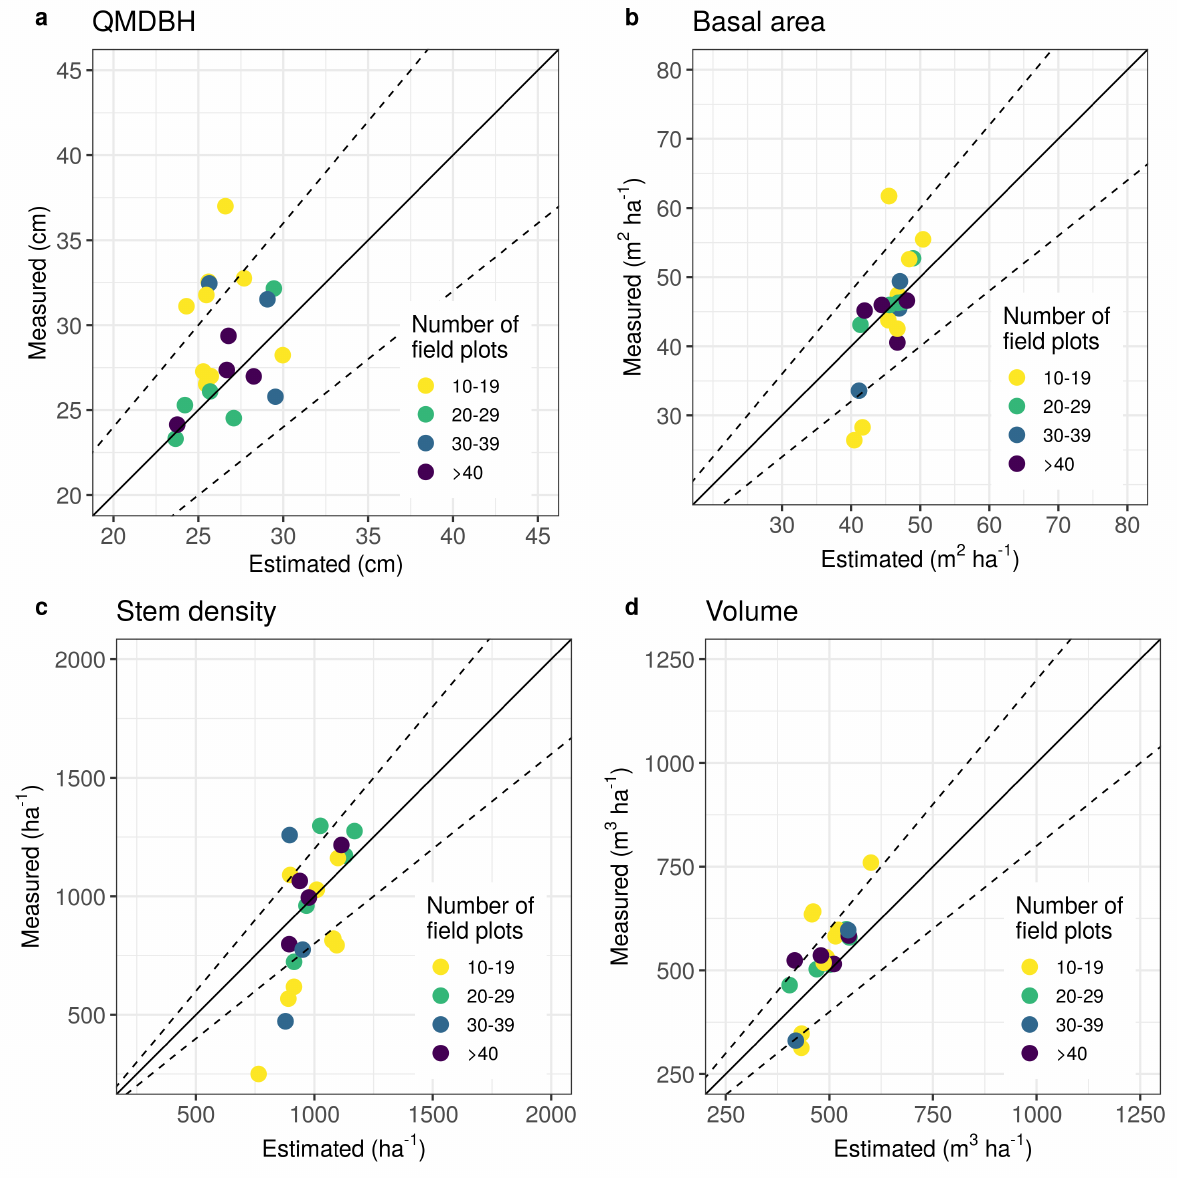
Figure 5. Random forest estimated versus measured ( a ) QMDBH, ( b ) basal area, ( c ) stem density, and ( d ) volume for a range of areas, a 1:1 line (solid), and 20% error lines